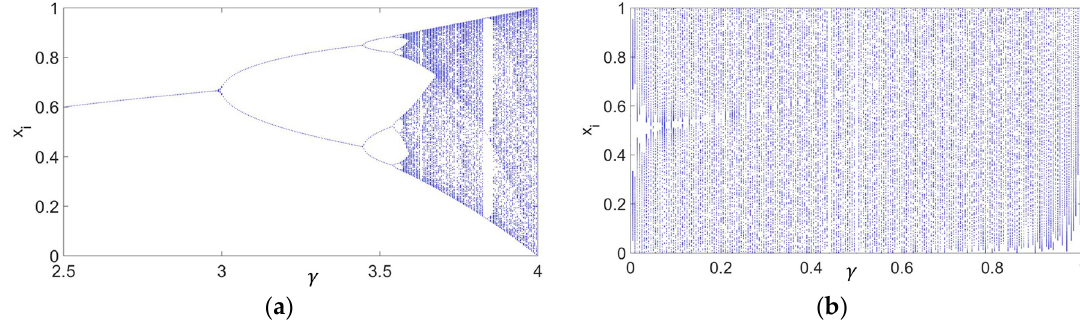
Figure 2. This figure represents several consecutive values of a sequence x i generated by different values of the chaotic parameter γ for: ( a ) The Logistic Map; ( b ) The Skew Tent